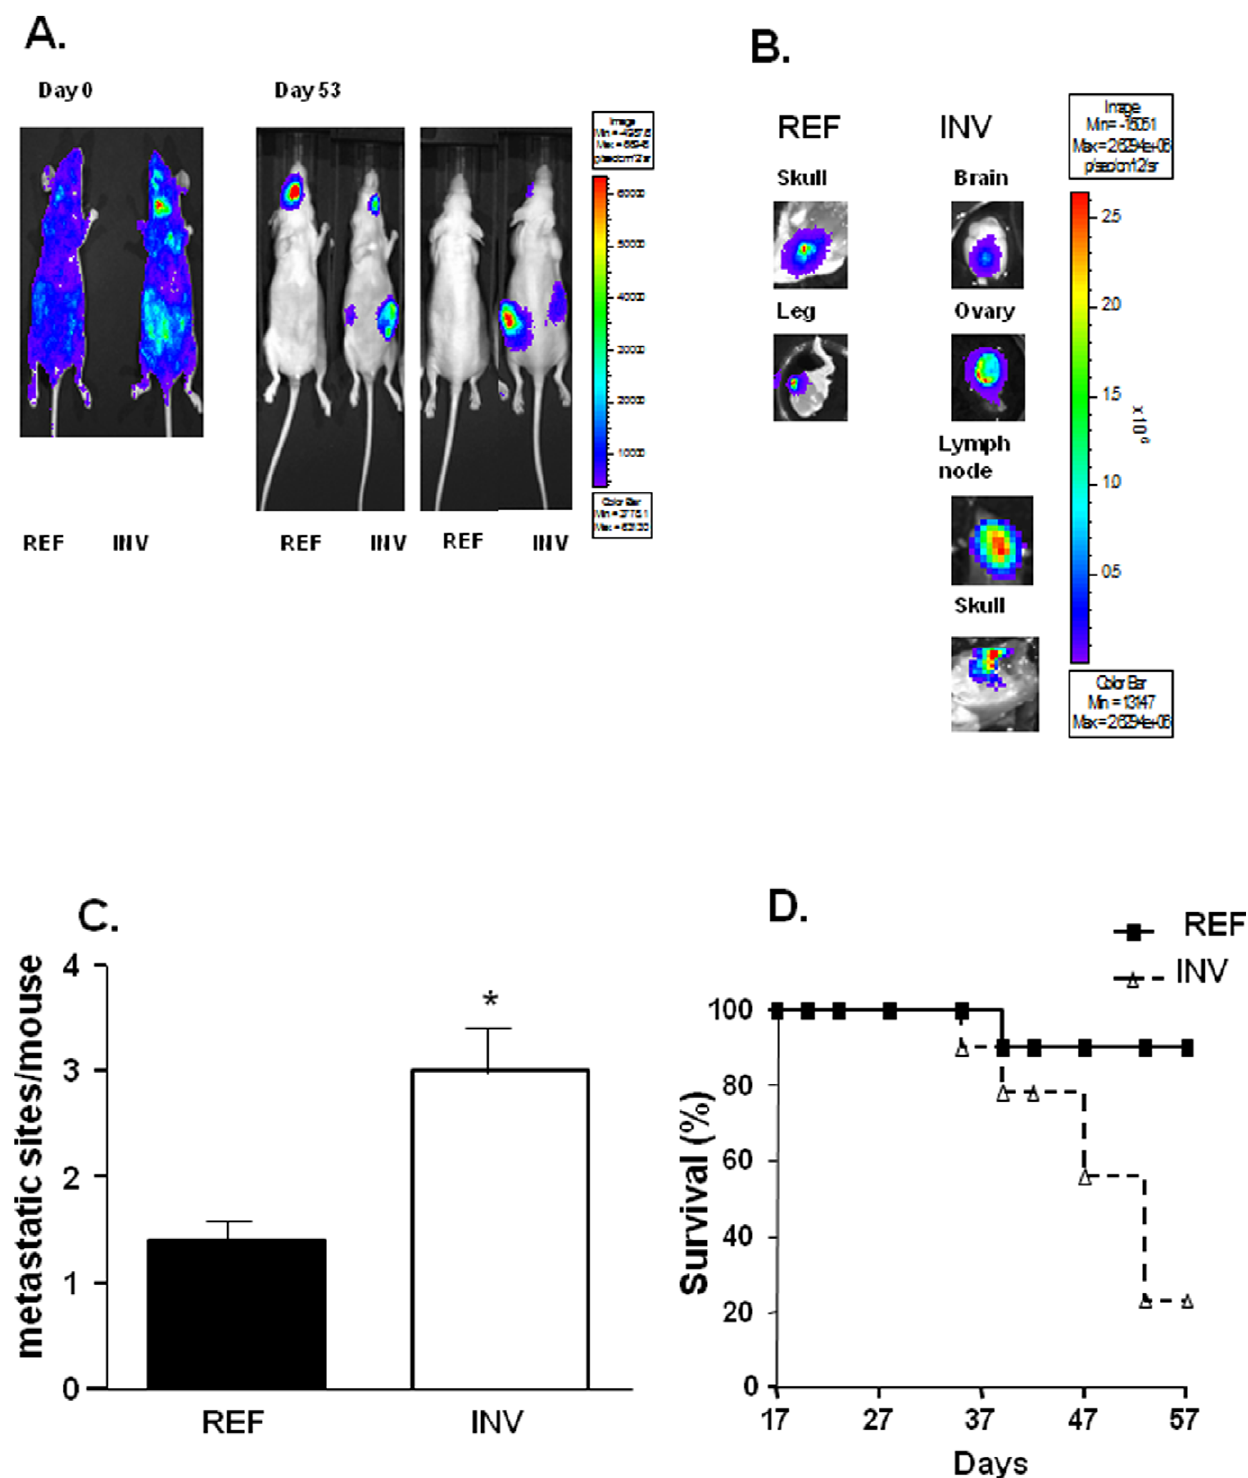
Figure 3. REF and INV metastasis formation. INV and REF cells (10 5 ) were injected into the left ventricle of nude mice (n=7, A). Ex vivo data confirm tissue metastasis from INV (right panel) and REF cells injection (left panel) (B). Quantification of metastatic sites (C). Mouse survival following injection of REF and INV cells (D). Each column shows means ( 6 SD) of representative experiments. * P versus control , 0.05.